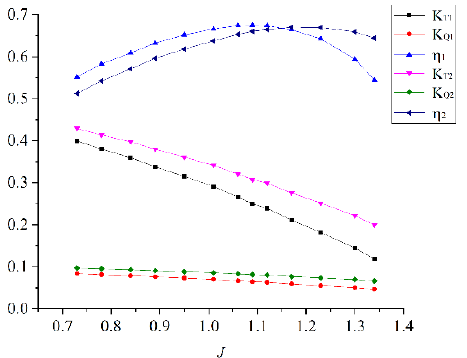
Figure 15. Comparison of two design methods hydrodynamic performance.